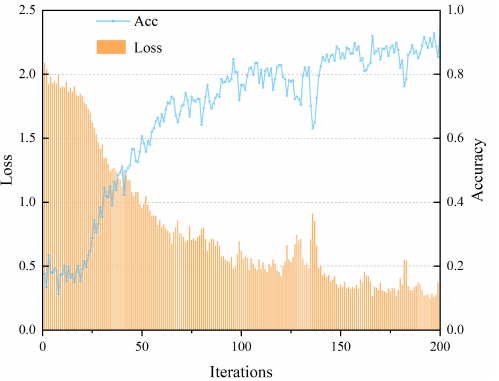
Figure 17. STCNN-model test results